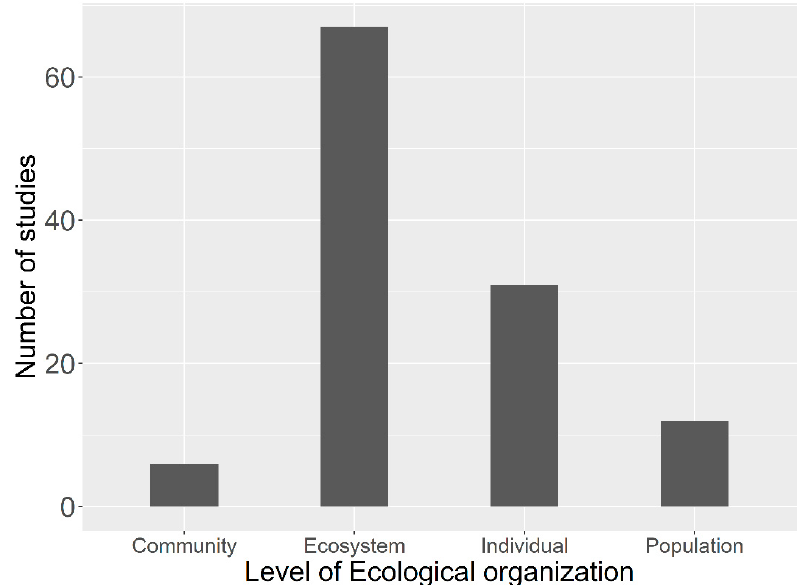
Figure 2. The number of studies that incorporate different levels of organization and their responses to climate change in the Tibetan Plateau. The studies that focus on more than one level get equal weight, adopted from Felton and Smith (2017) with modification. Studies were found and reviewed by searching the Web of Science and Google Scholar using the key words: climate